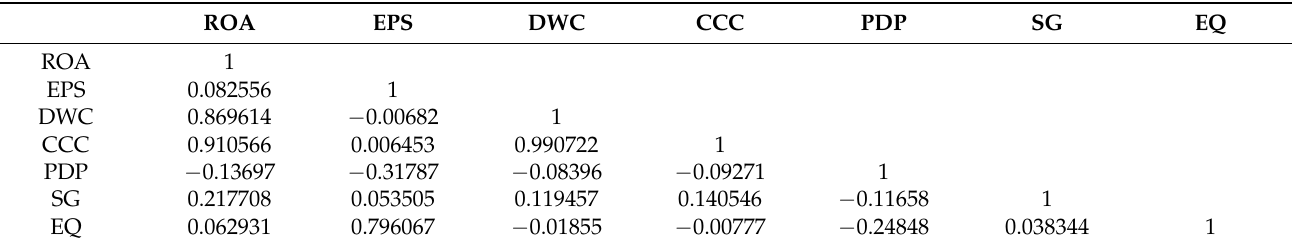
Table 3. Correlation statistics for the variables.